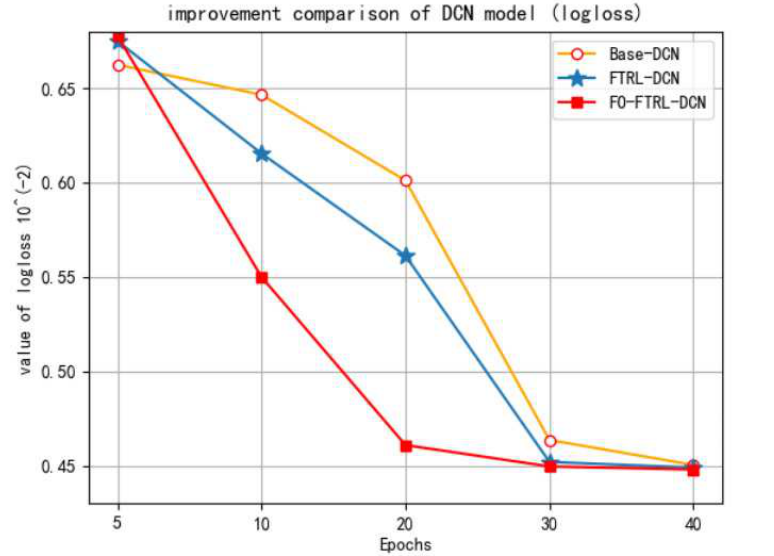
Figure 4. The comparison of DCN model